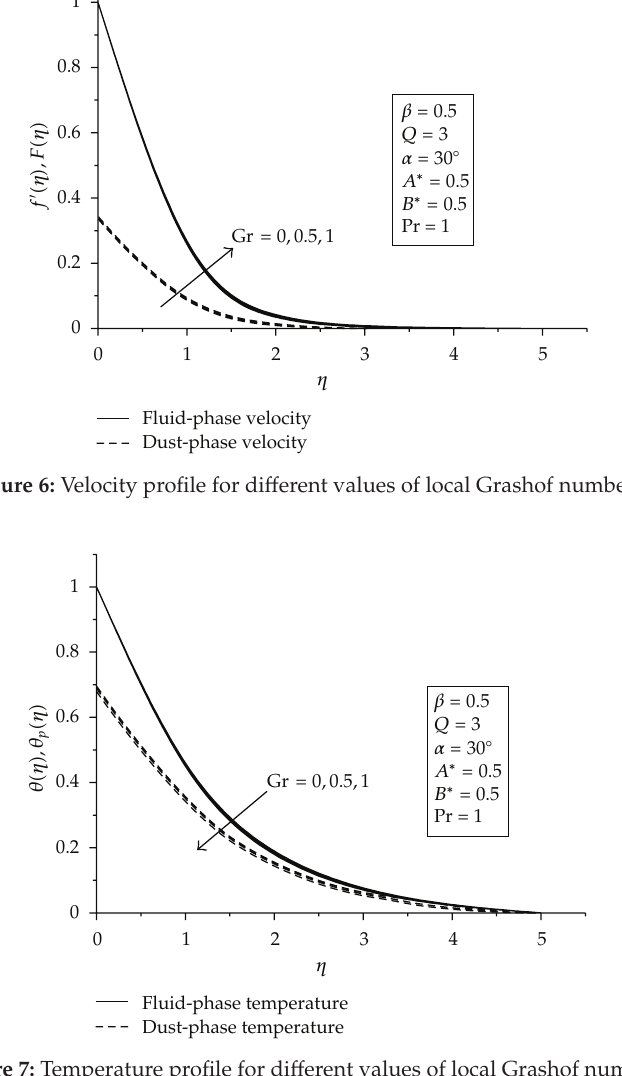
Figure 7: Temperature profile for di ff erent values of local Grashof